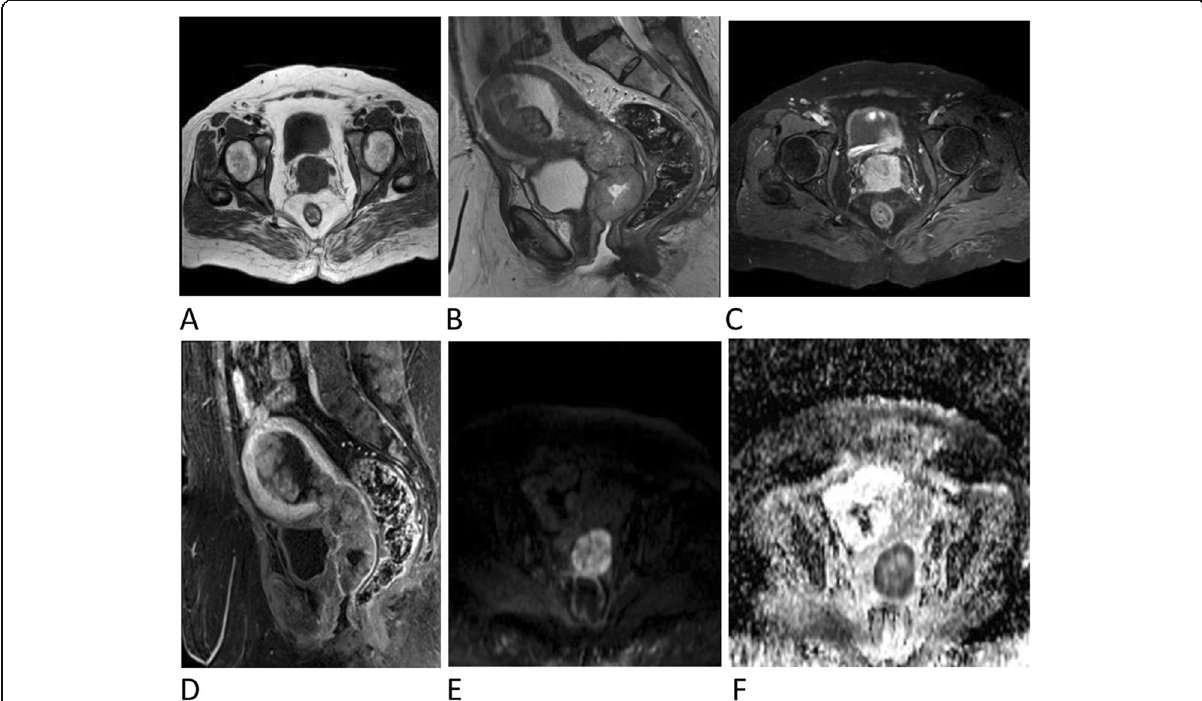
Fig. 2 A 49-year-old female patient presented with vaginal bleeding. MRI pelvis was done. a , b Axial T1WI and sagittal T2WI revealed irregular polypoidal intermediate signal intensity lesion seen mainly harboring the cervical canal extending downward to the upper portion of the vagina and upward to the endometrial cavity with a subsequent irregular widening of the cervical canal and uterine cavity. c , d Axial and sagittal late post-contrast, the lesion showed non-homogenous irregular enhancement at the late post contrast sequence with invasion of the parametrium. e , f DWI, the lesion showed signal restriction with high b value (800) with corresponding low signal at ADC map. Diagnosis: cervical carcinoma